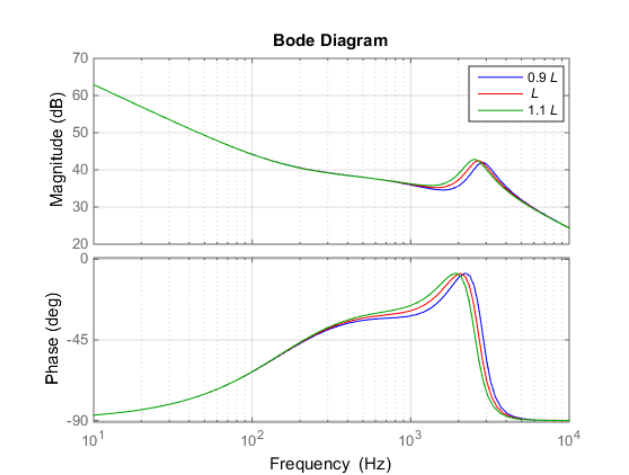
Fig. 7. The inverter output impedance sensitivity to inductance variation